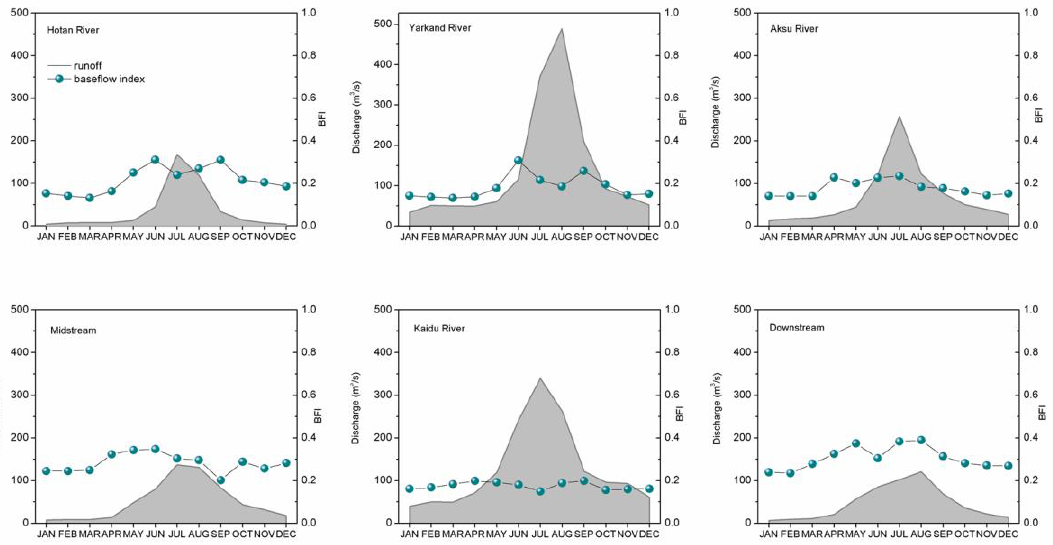
Figure 2. Monthly variations of runoff and baseflow index in the Tarim River Basin. Data for runoff is from last 30 years and data for baseflow index is from 1972 to 2007.